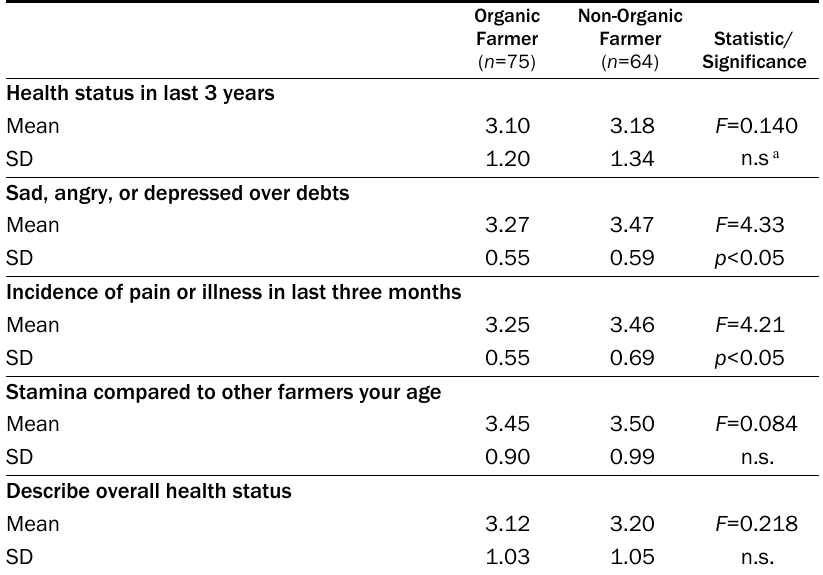
Table 4. Differences Between the Health Views of Organic and Non-Organic Farmers